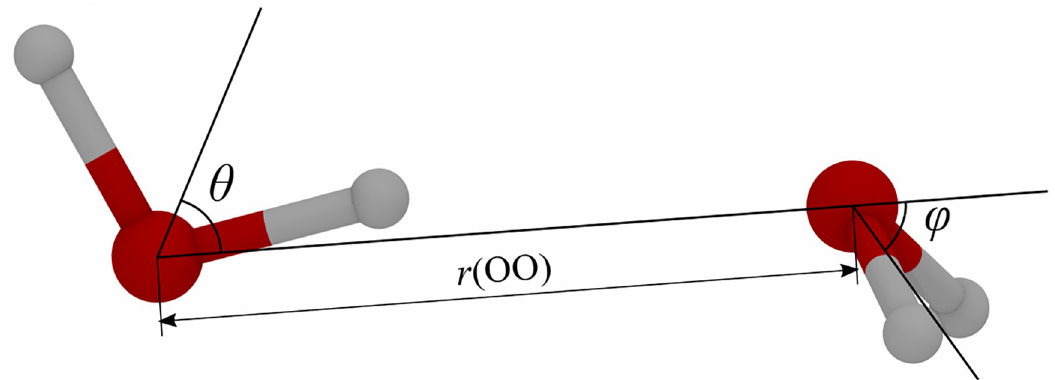
Fig 2. Schematic of a water dimer. r (OO) is the distance between the two oxygens; θ and φ are the angles between water molecule’s C 2 axis and the O-O line for the two molecules respectively